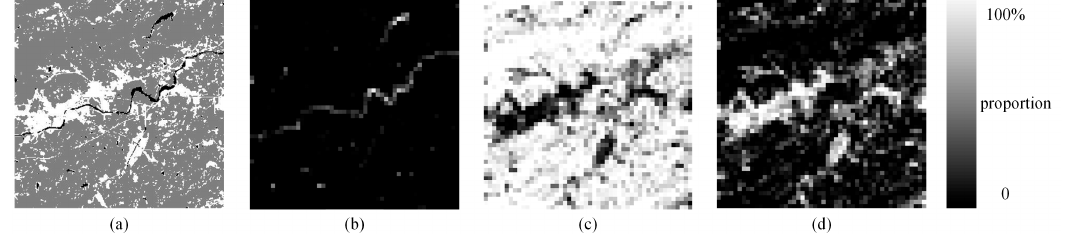
Figure 12. Proportion images of three classes with a scale of 8. ( a ) Reference image, ( b ) water, ( c ) vegetation, ( d ) soil.